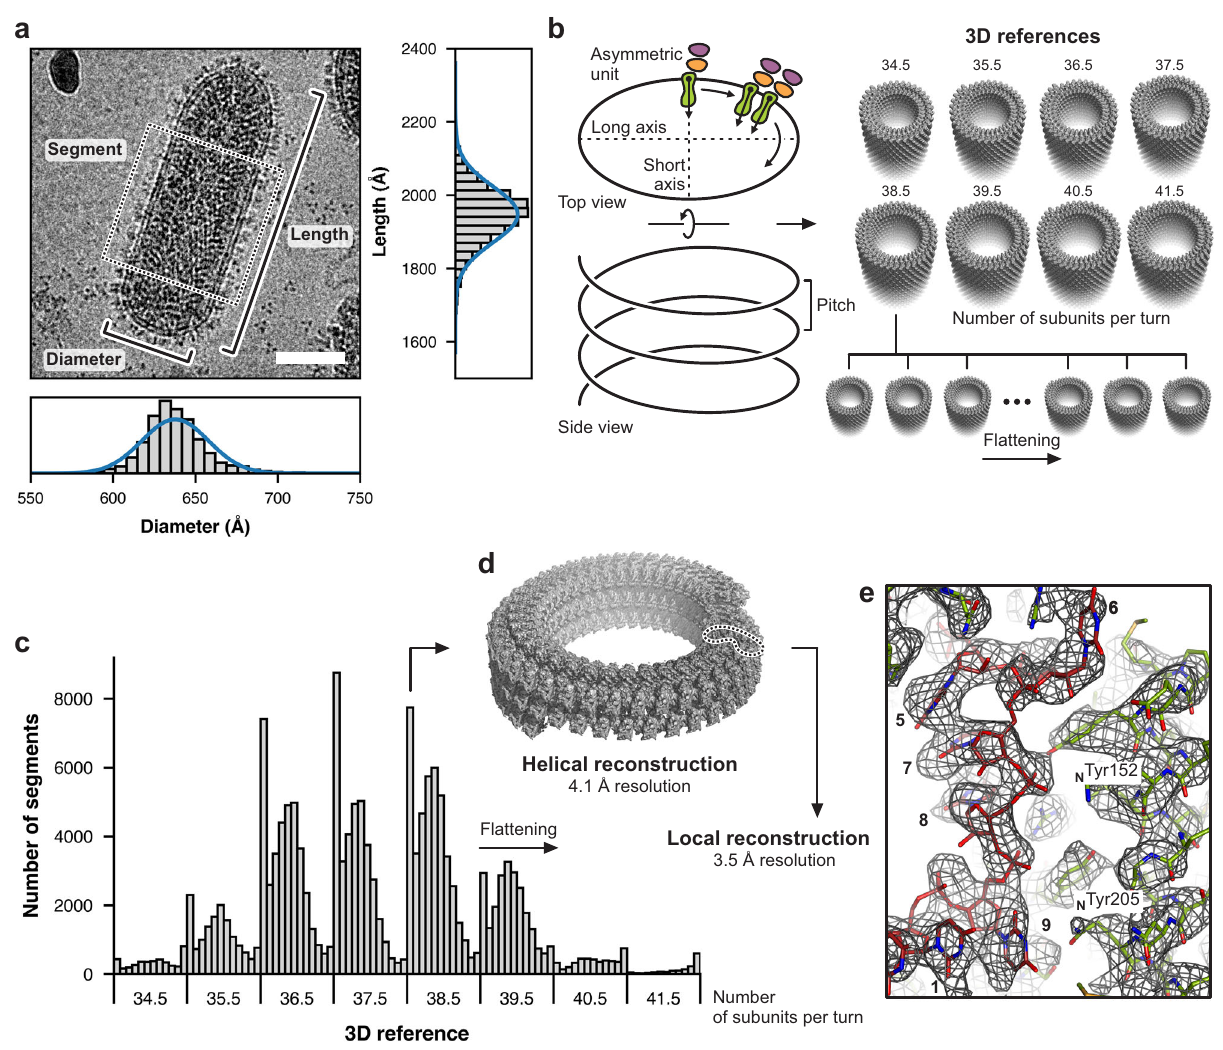
Fig. 1 | Cryo-EM analysis of the helical VSV nucleocapsid. a Cryo-EM image of a bullet-shaped vesicular stomatitis virus (VSV) particle. The image was low-pass fi lteredandcontrastenhanced.Thescalebarcorrespondsto50nm.Thehorizontal and vertical histograms show the distribution of measured diameter and length, respectively,from5763individualparticles.Measurementsweretakenbetweenthe middle of the lipid bilayers as indicated and possible out-of-plane tilting was ignored. The solid blue lines are normal distribution fi ts to the histograms with means and standard deviations of 638±20Å for the diameter and 1947±76Å for the length. The dashed box shows one segment image extracted along the VSV trunk. b Preparation of 3D references for supervised classi fi cation. Density of one asymmetricunitinitiallyobtainedfromalowresolutionreconstructioncomprising